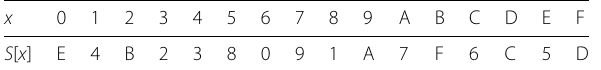
Table 5 The S-box used in